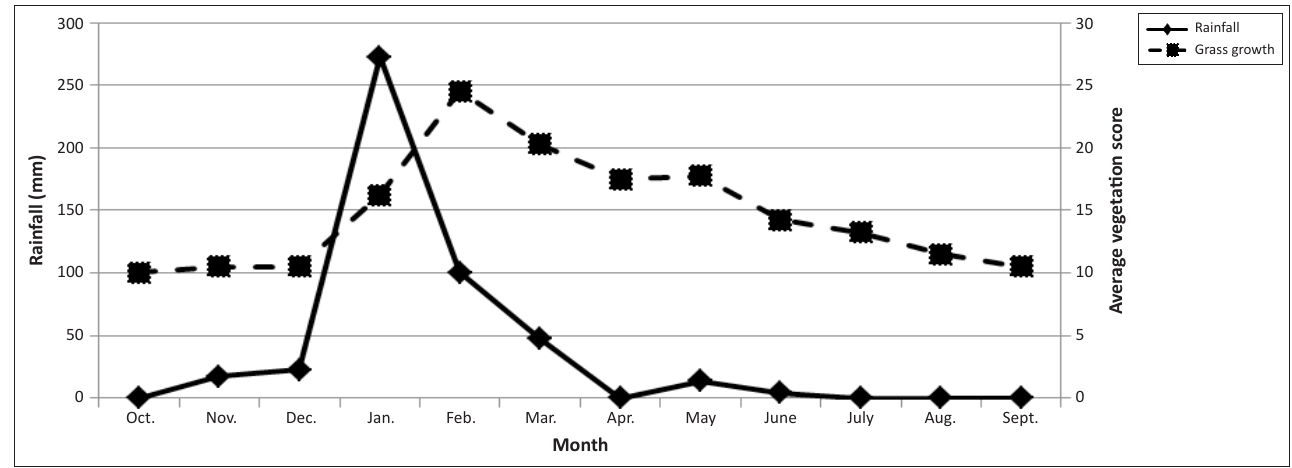
FIGURE 2: Seasonal comparison of rainfall and grass cover